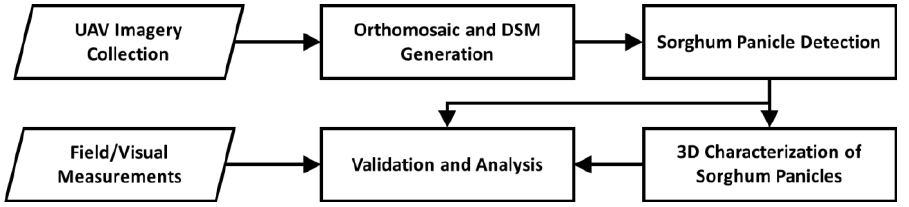
Figure 1. A workflow of sorghum panicle characterization.